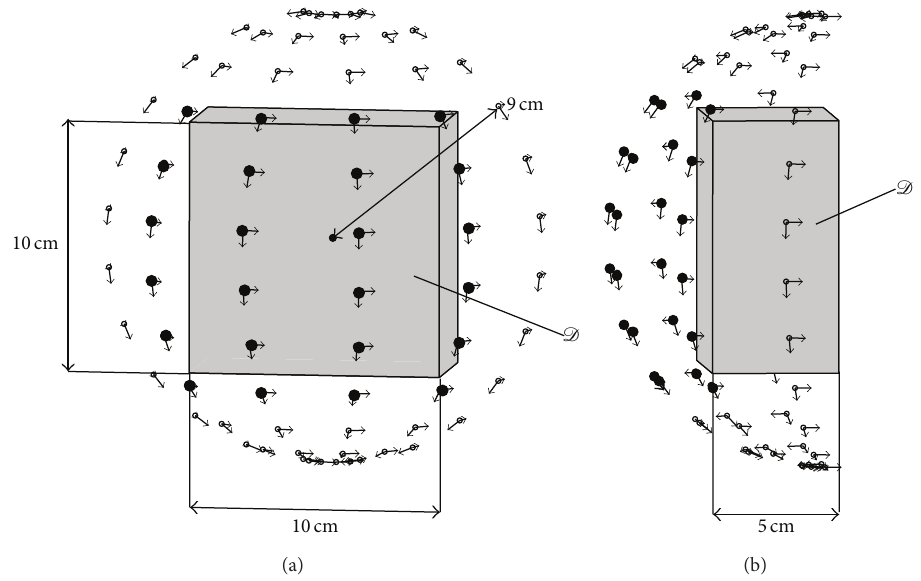
Figure 10: Views on the investigation domain D and the dipole configuration for the simplified breast phantoms: front view (a), side view (b). The arrows visualize the dipole orientations and the large black dots indicate positions with both transmitters and